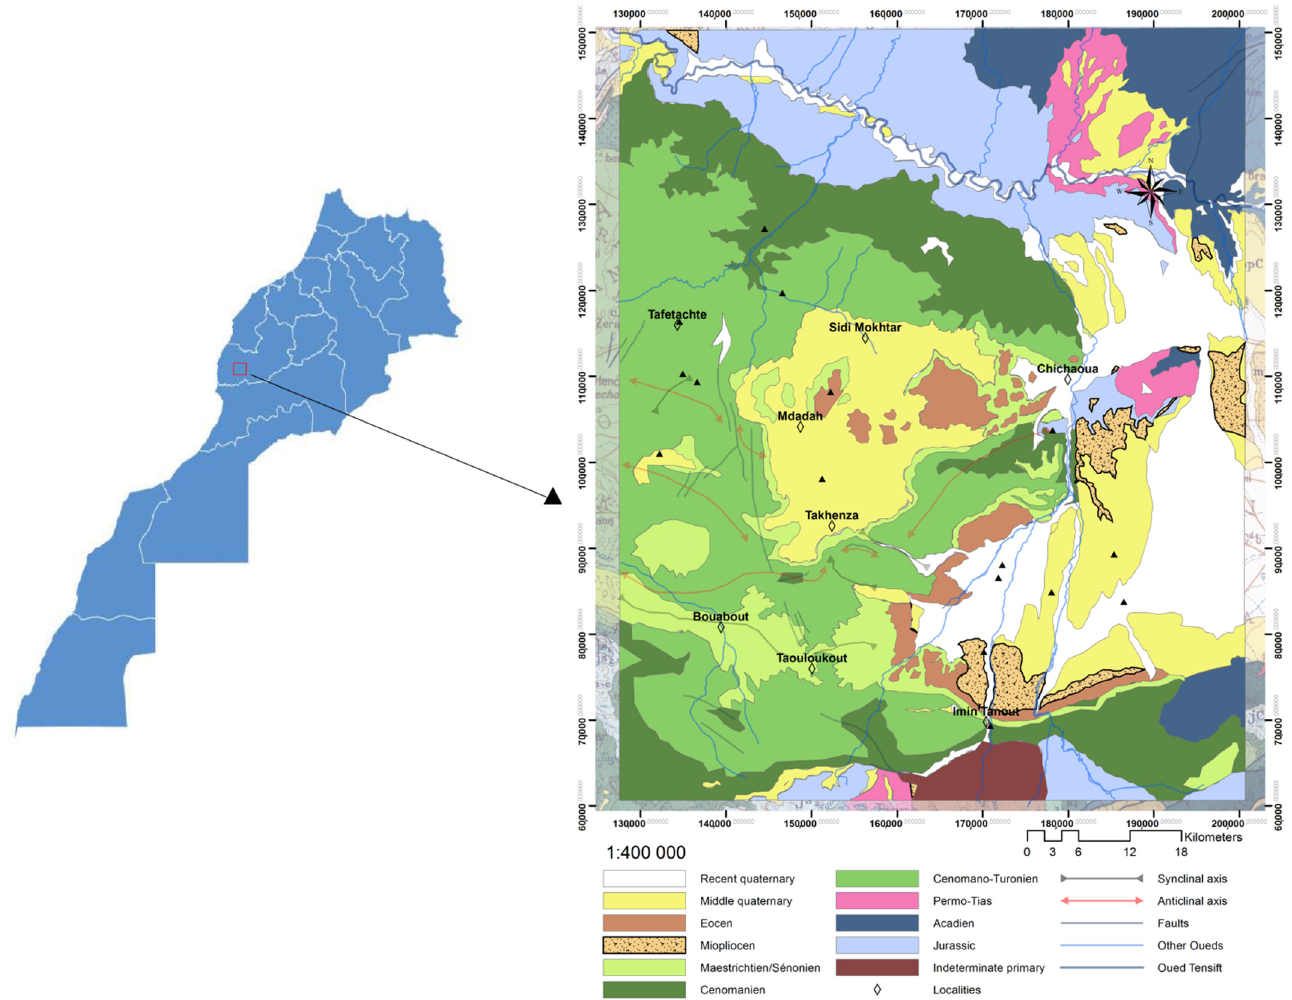
Figure 1. Geographical location and Geology of OuledBouSba â basin (according to the 1:50,000 geological map of Morocco).